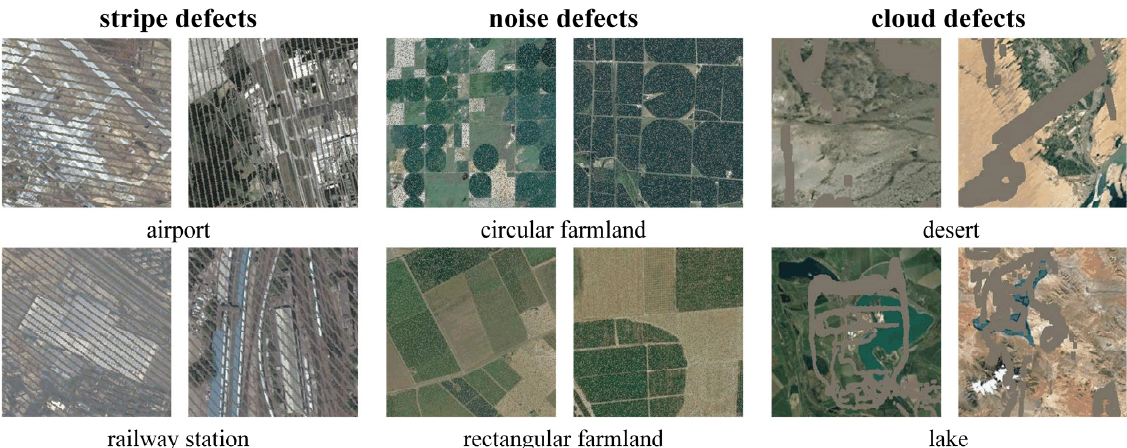
Figure 14. Example of typical misclassifications. The backgrounds of the images in the first row and the second row are much similar.